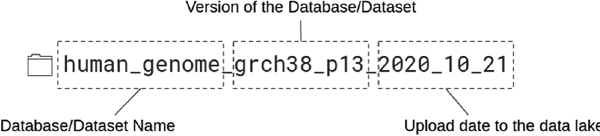
Figure3.AnexamplenamingconventionfordatastoredinsidetheDataLake. Thefirstpartofthefoldernameis thenameofthegivendatabase/dataset.Inthisexamplecase,thehumangenome.Thenextpartistheversionofthe data, and the last is the uploaded date to the Data Lake. https://jsonlines.org/